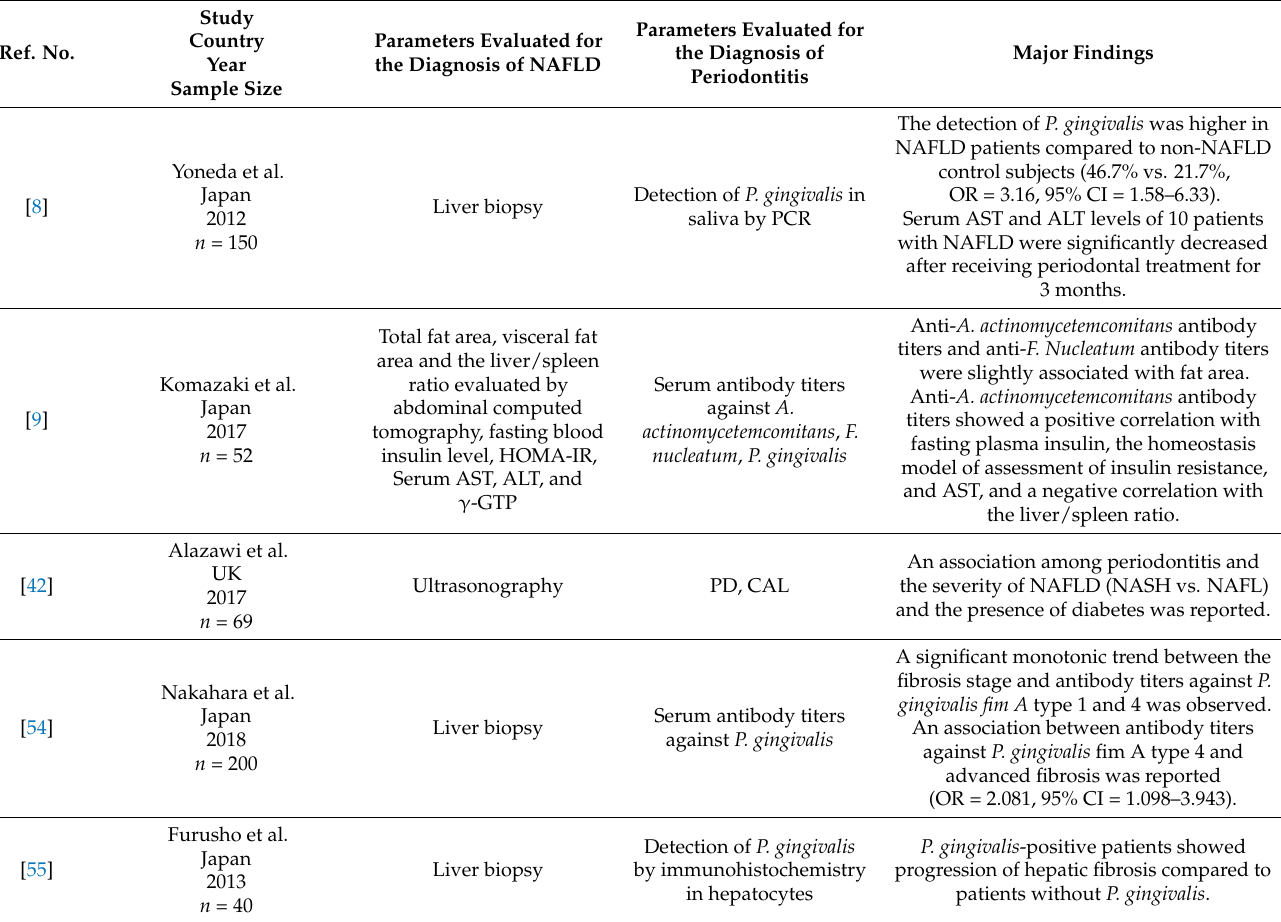
Table 4. Studies regarding periodontal disease in patients with